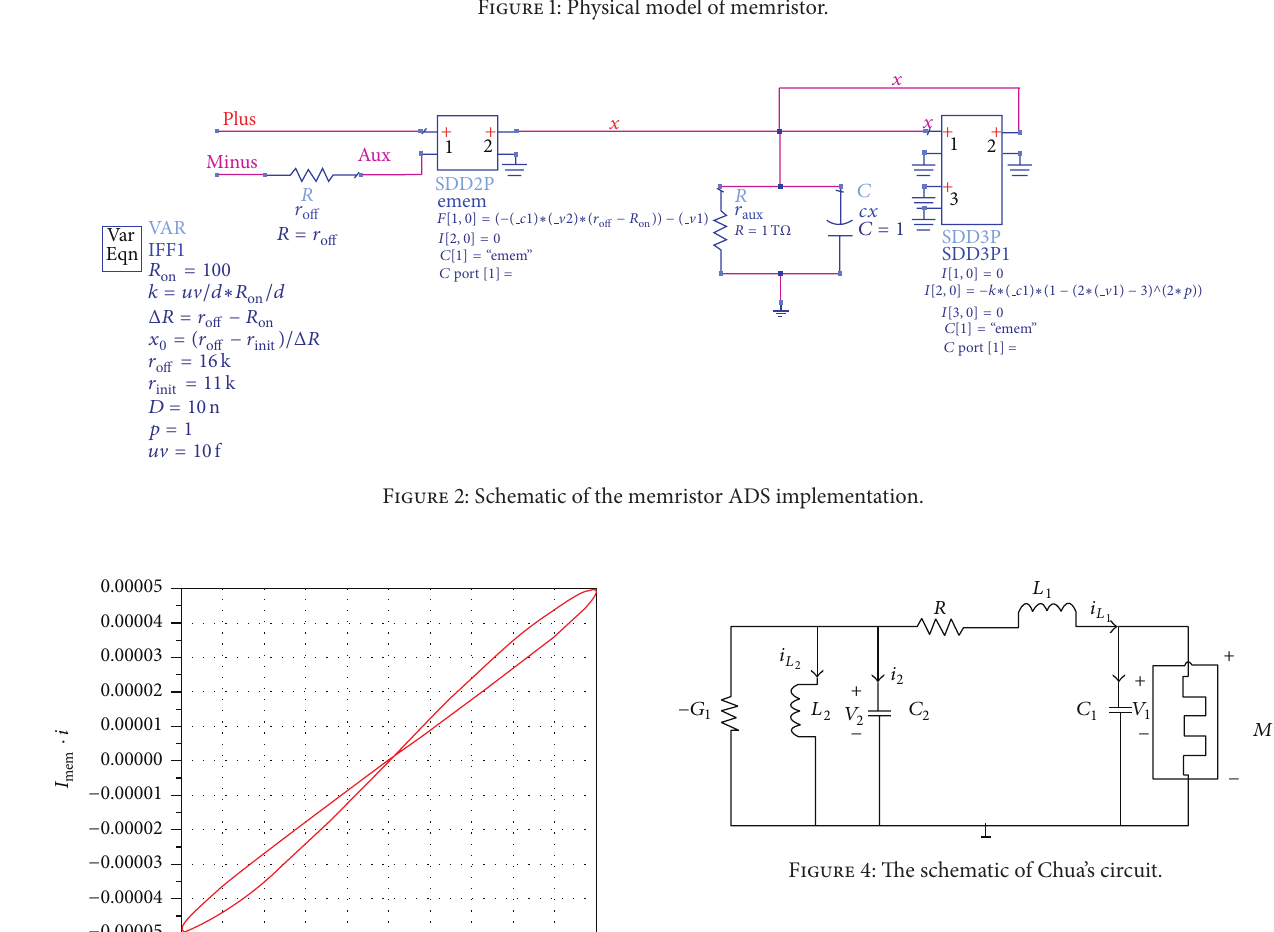
Figure 1: Physical model of memristor.